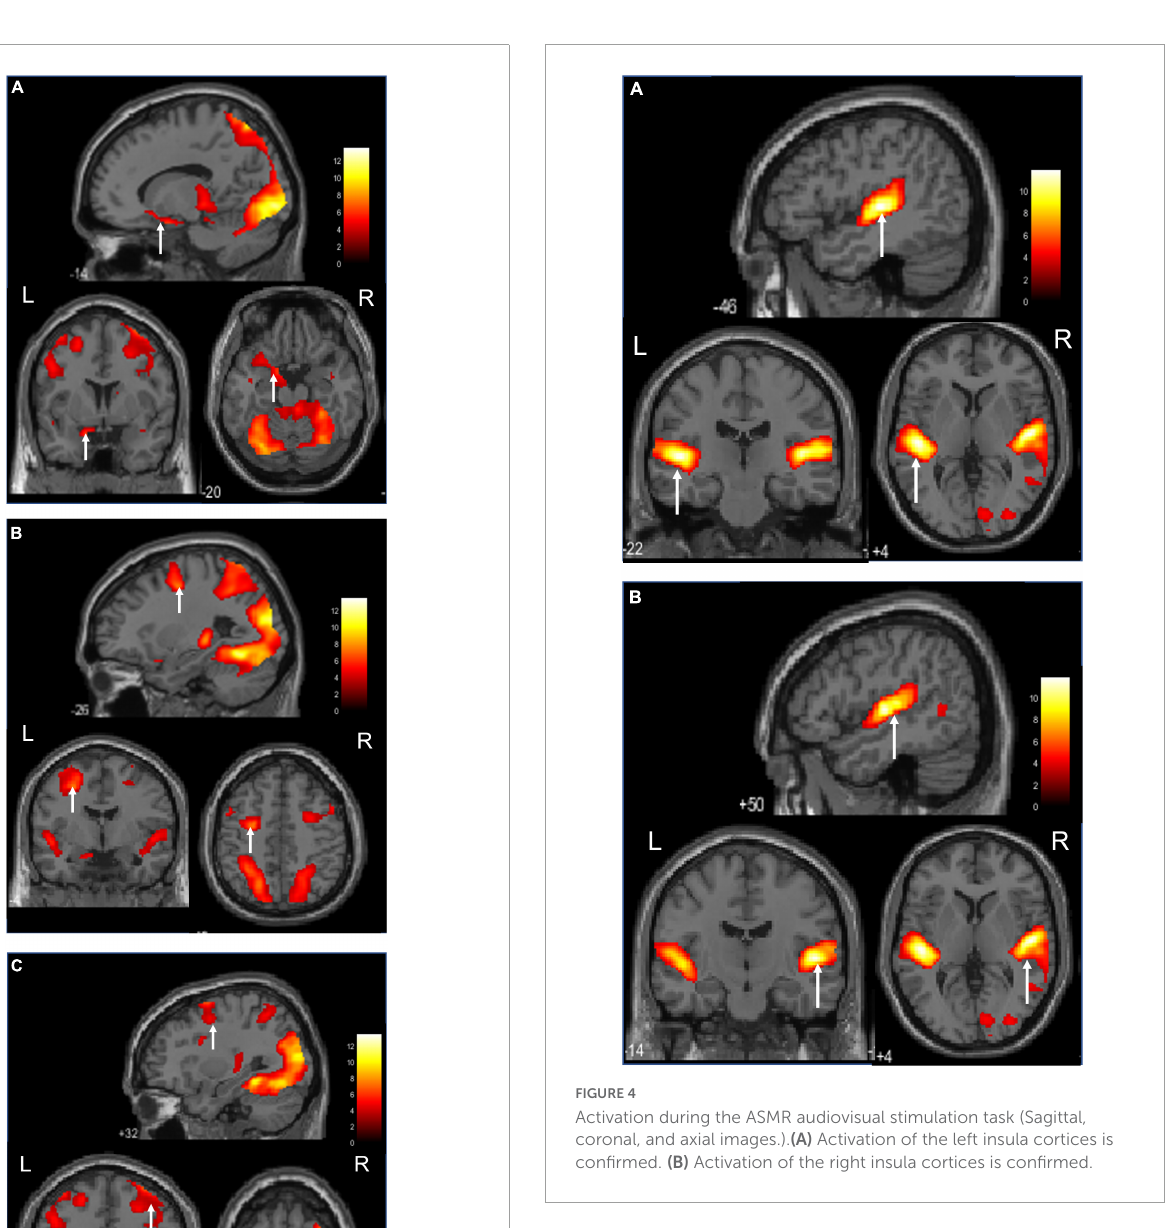
to the audiovisual stimulation condition were the left middle occipital gyrus, right precuneus, right angular gyrus, and left lateral ventricle. Their T -values and coordinates are shown in Table 3